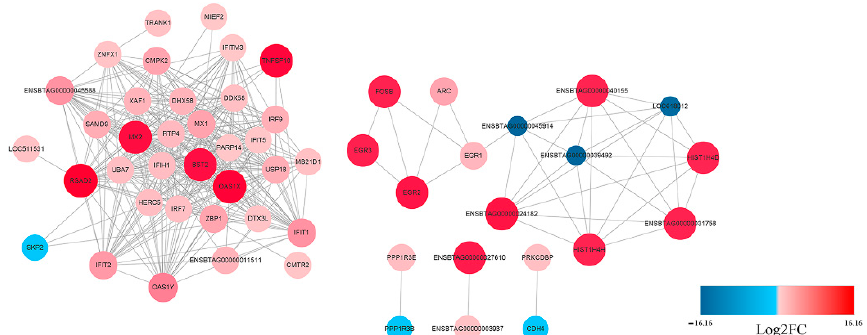
Figure 5. Protein – Protein Interaction (PPI) network of the selected DEGs based on STRING analysis results and fold change information. The network nodes represent the proteins encoded by the DEGs. The up-regulated genes are shown in red, and the down-regulated genes are shown in blue, with the gradient showing the extent of expression. The size of the node indicates connectivity. A detailed representation of DEGs is provided in Table S1.